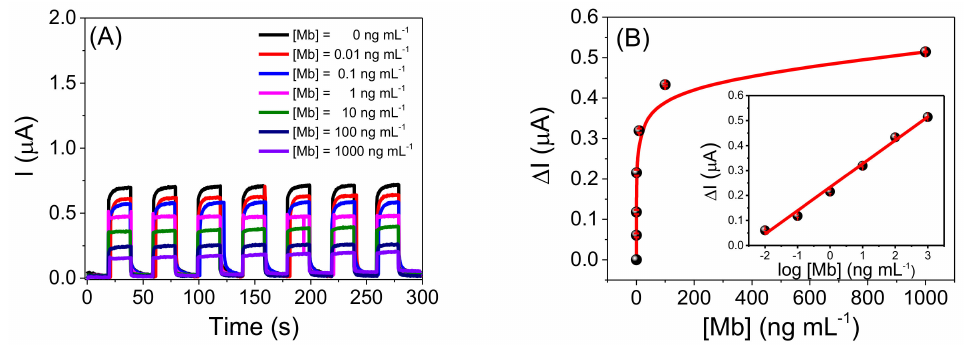
Figure 5. ( A ) Amperograms for the anti-Mb/CdSeS/ZnSQDs/BTO/FTO immunosensor pho- toelectrochemical before incubation, [Mb] = 0 ng mL − 1 , and after incubation of different [Mb] (0.01–1000 ng mL − 1 ); ( B ) Plot of the variation photocurrent for the photoelectrochemical immunosen- sor vs. [Mb] obtained from Figure 5A. Inset of Figure 5B: Plot of the log [Mb] vs. photocurrent response obtained for the anti-Mb/CdSeS/ZnSQDs/BTO/FTO photoelectrochemical immunosensor. Experiments performed in 0.10 mol L − 1 PBS, pH 7.4 containing 0.25 mol L − 1 of VC applied potential of applied potential of 0 V and incubation time of 0.67 h.